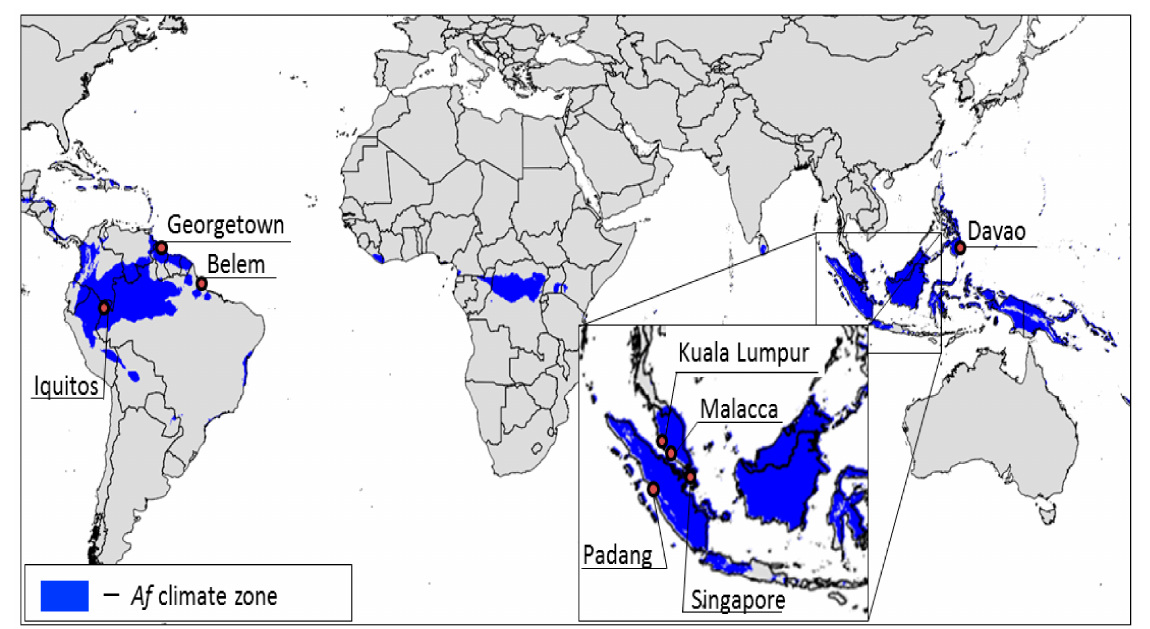
Figure 2. The territory of the tropical rainforest climate (Af) on the world map [27].